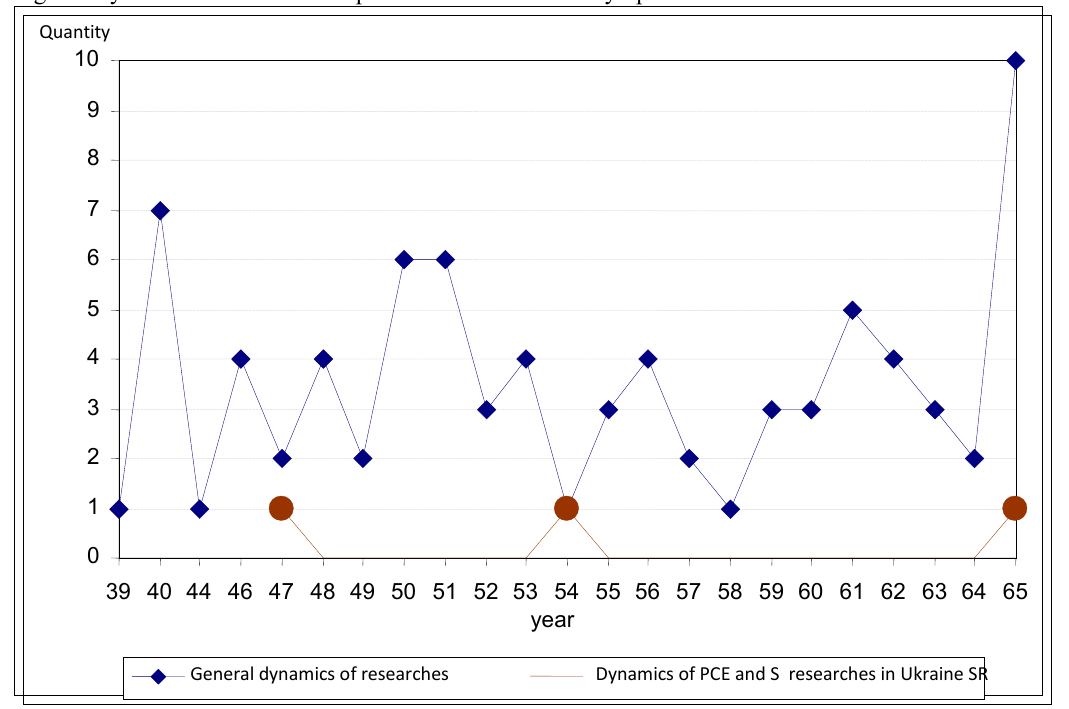
Fig.1. Dynamics of dissertation researches